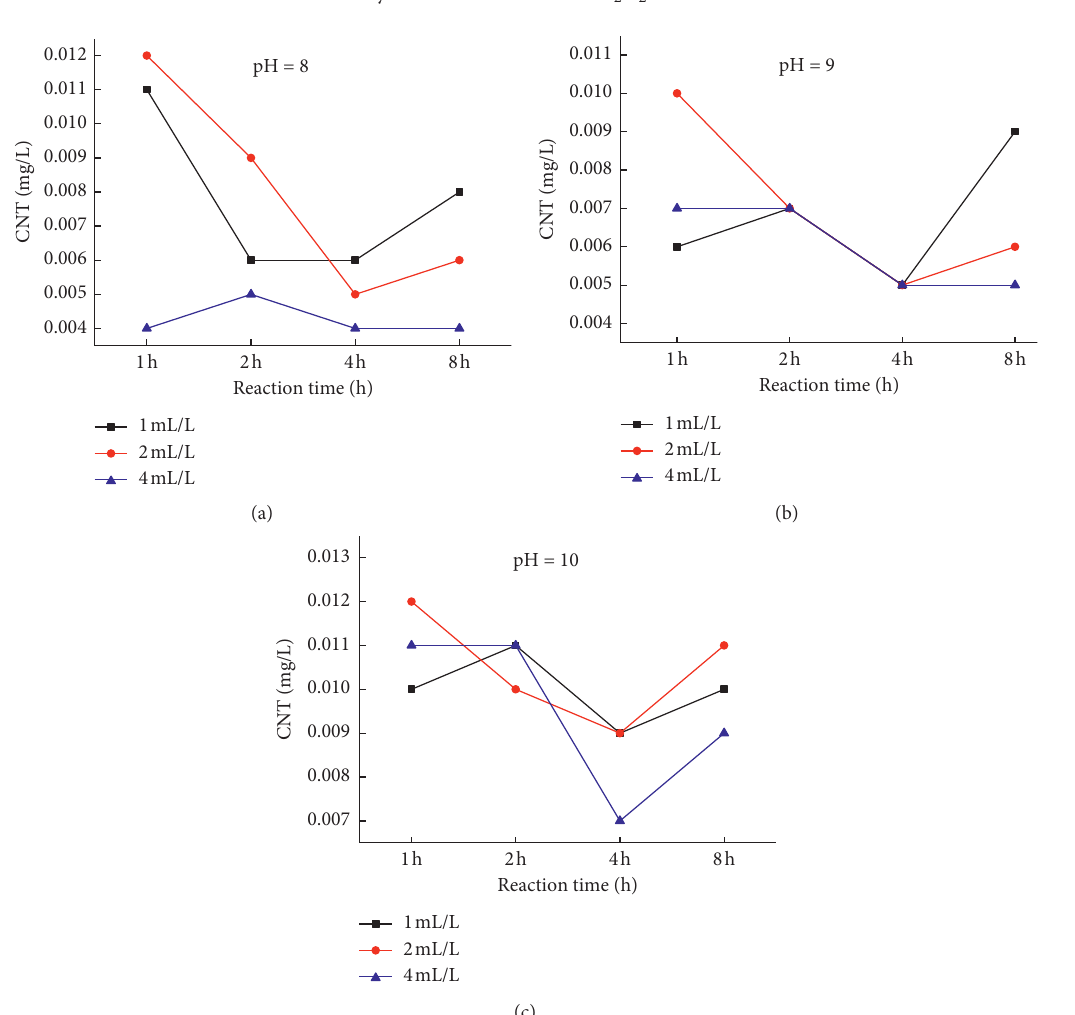
2 O 2 concentration.